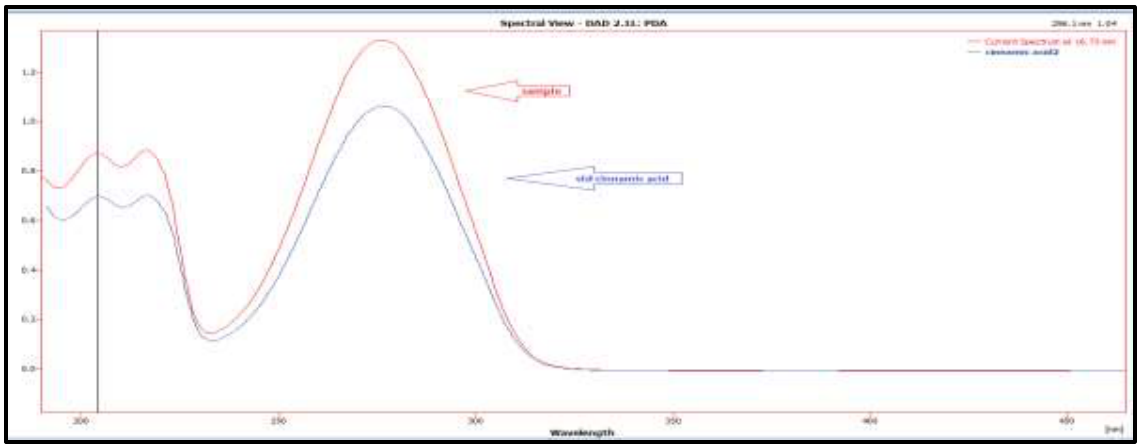
Figure 10. UV spectrum for cinnamic acid standard and isolated compound(A1). LC/MS of isolated compounds A4(1) and A6(3) isolated by (PLC) and A1 isolated by (HPLC).